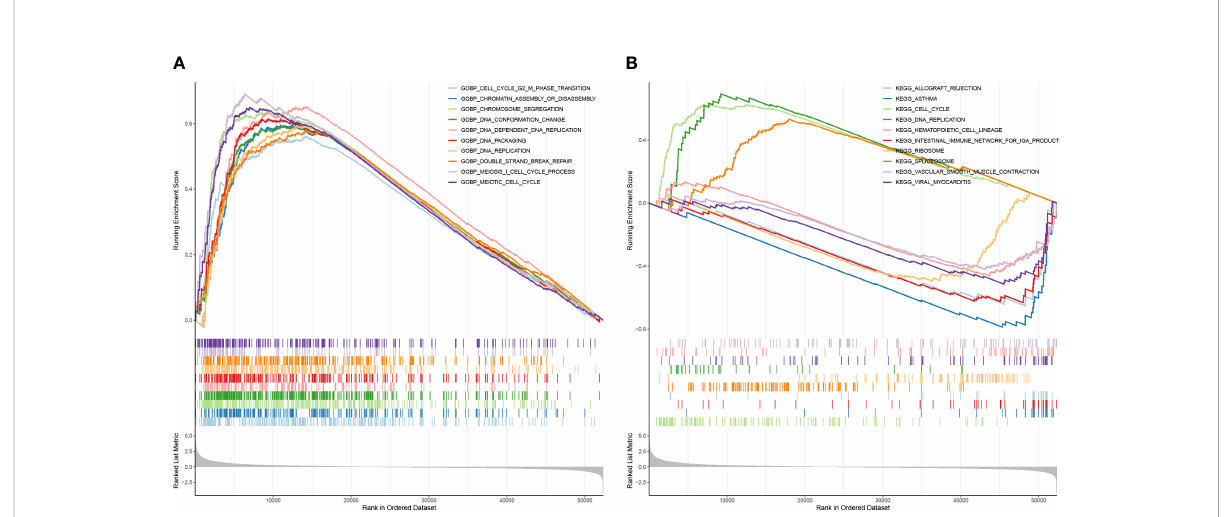
FIGURE 8 The risk score had a close relationship with cell proliferation. (A) GSEA enrichment analysis for high and low-risk groups — GO enrichment analysis. (B) CSEA enrichment analysis for high and low-risk groups – KEGG pathway